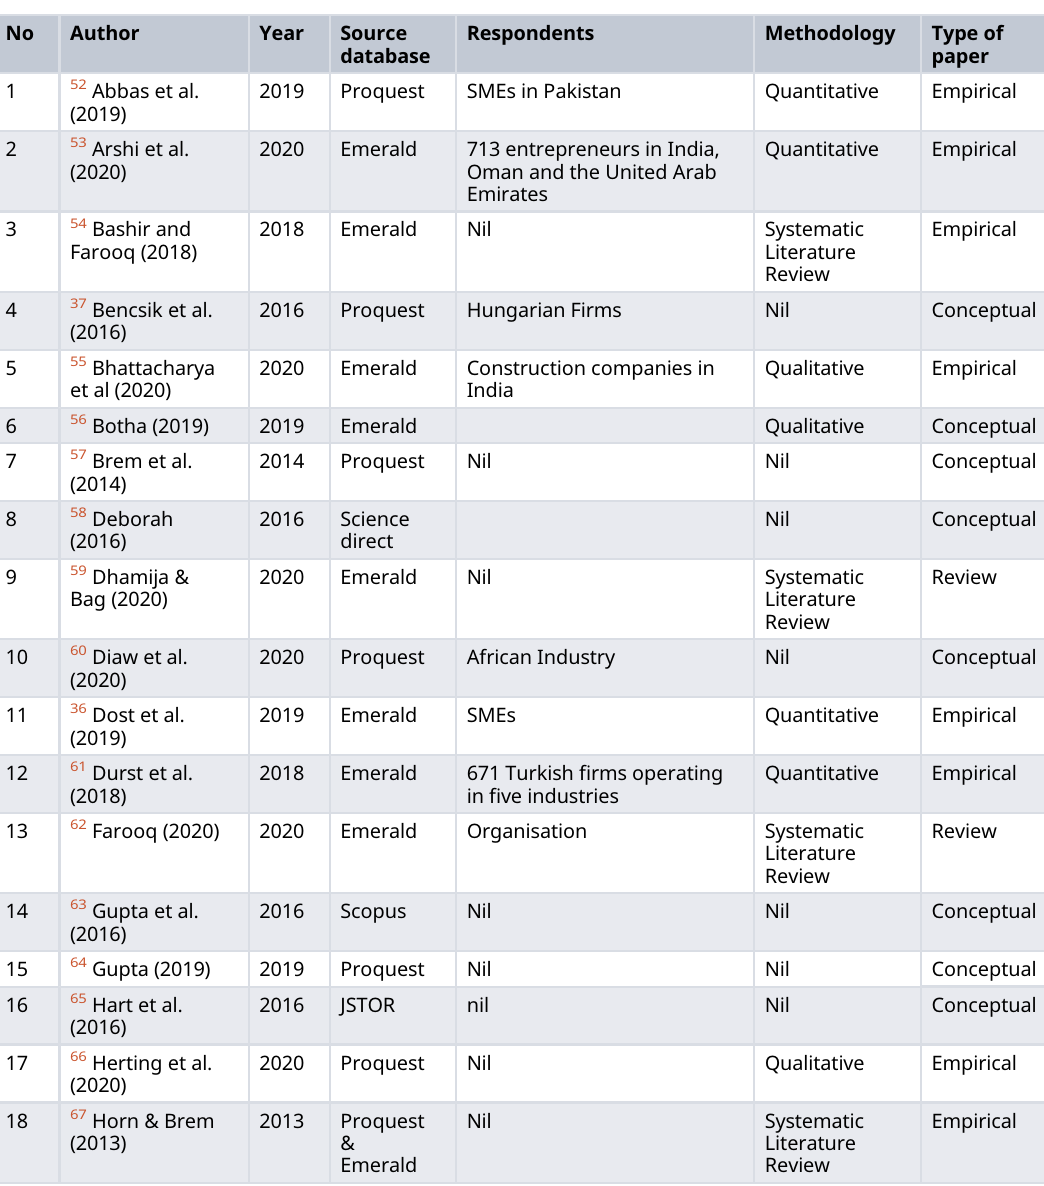
Table 3. Descriptive information of the 34 core